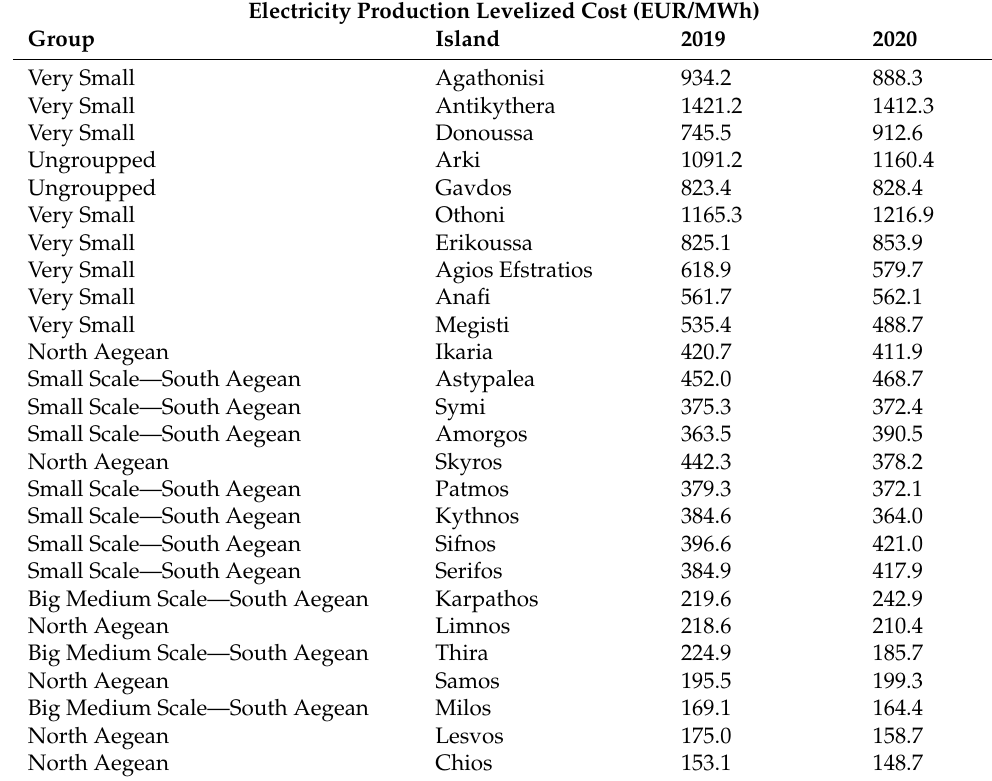
Table 2. Electricity production levelized cost in Greek insular autonomous electrical systems in 2012 and 2013